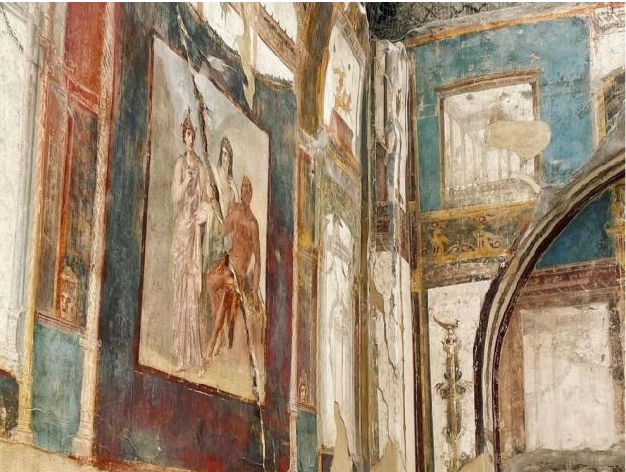
Figure 2. View of the interior of a domus of Herculaneum Archaeological Park [31].